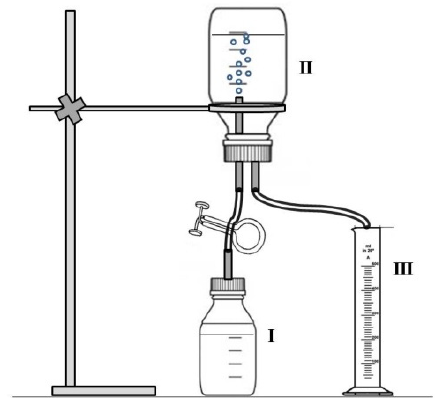
Figure 7. Volume determination apparatus for hydrogen produced. (I) Bioreactor with a biogas outlet, (II) inverted flask with a 3 N NaOH solution, and (III) test tube for the quantification of bioH 2 volume (Aguilar-Aguilar et al. 2017 [9]).